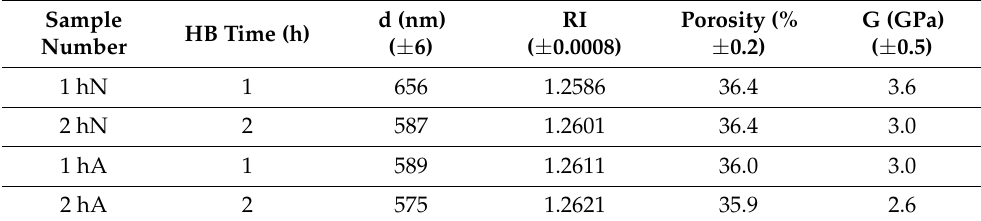
Table 1. Description of OSG samples with different curing times in nitrogen (N) and air (A). All characteristics presented in Table 1 were measured on witness Si samples without an Al